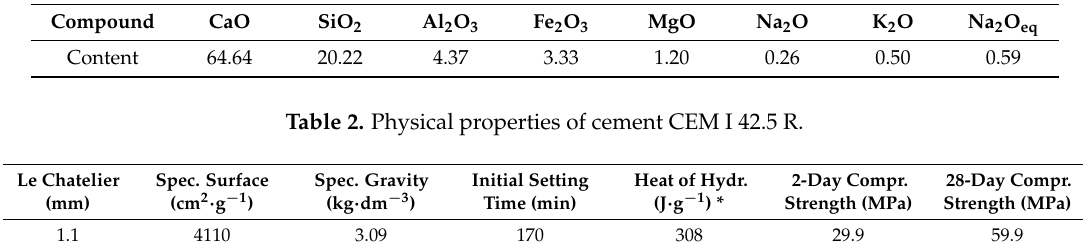
Table 1. Chemical composition and alkali content in cement clinker CEM I 42.5 R, %.